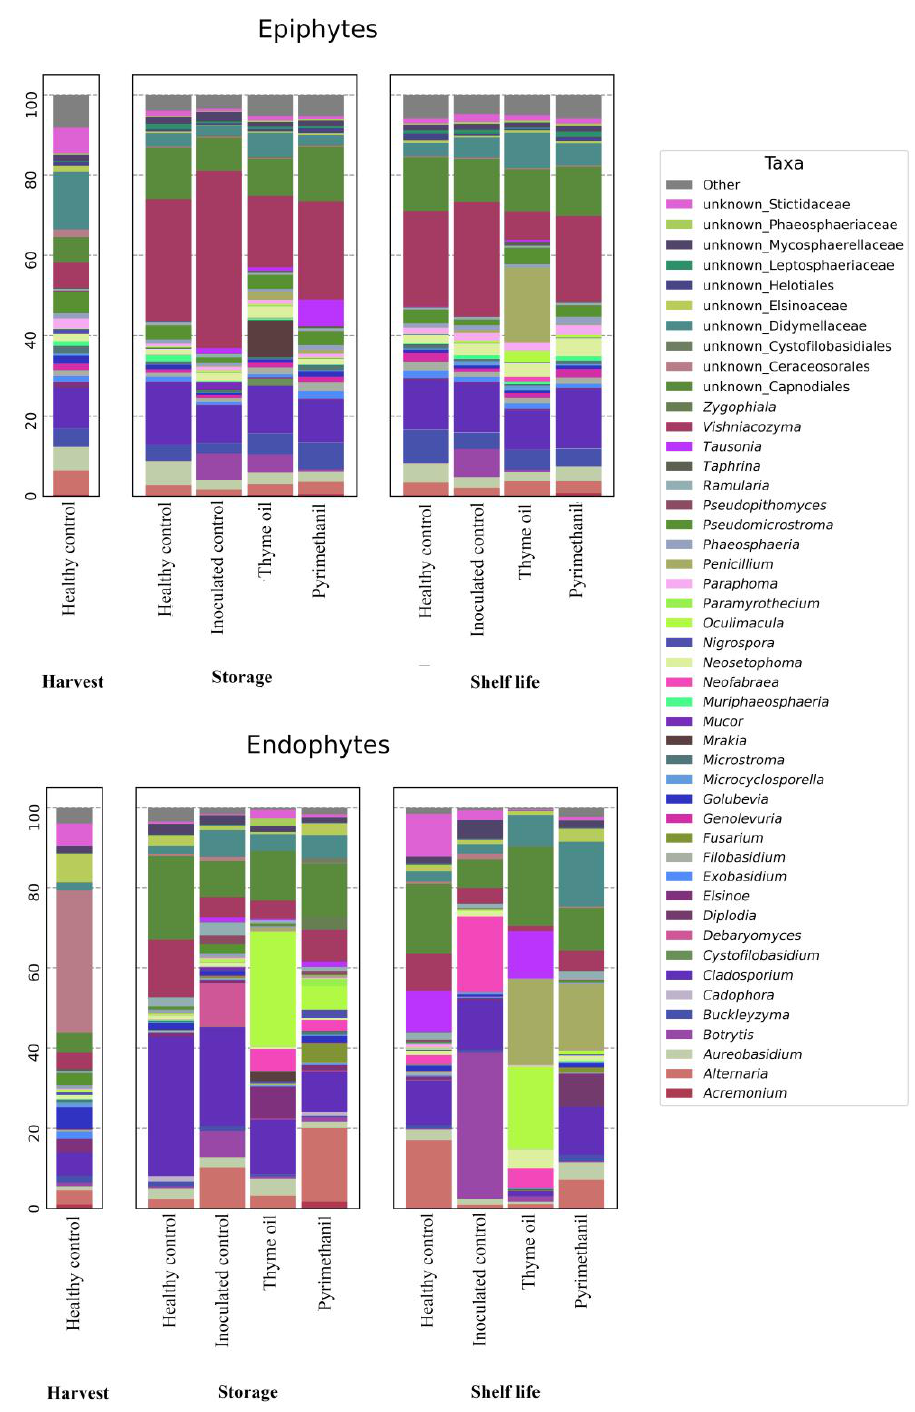
Figure 4. Taxa composition of epiphytic and endophytic fungal communities. The “Other” category includes all taxa with less than 1% relative presence in all considered groups.